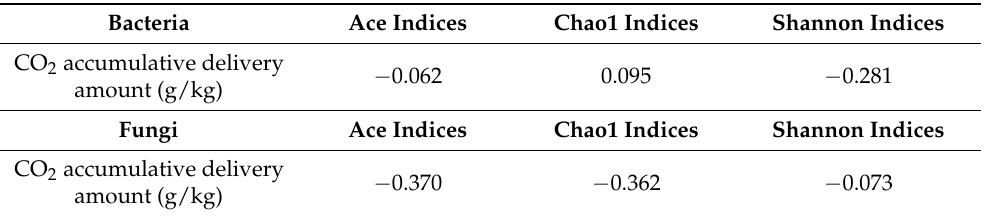
Table 7. Correlation analysis between cumulative CO 2 release and soil microbial diversity after pyrogallic acid